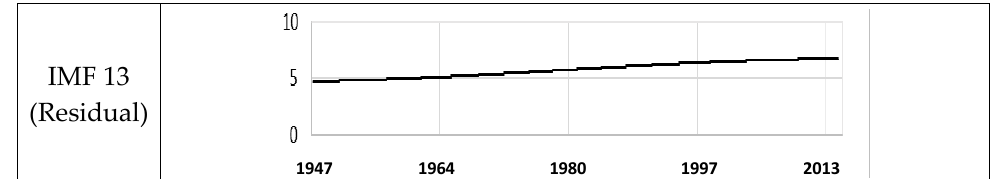
Figure 3. Intrinsic mode functions IMFs from the SLIA station. Note the scale differences on the individual IMFs.